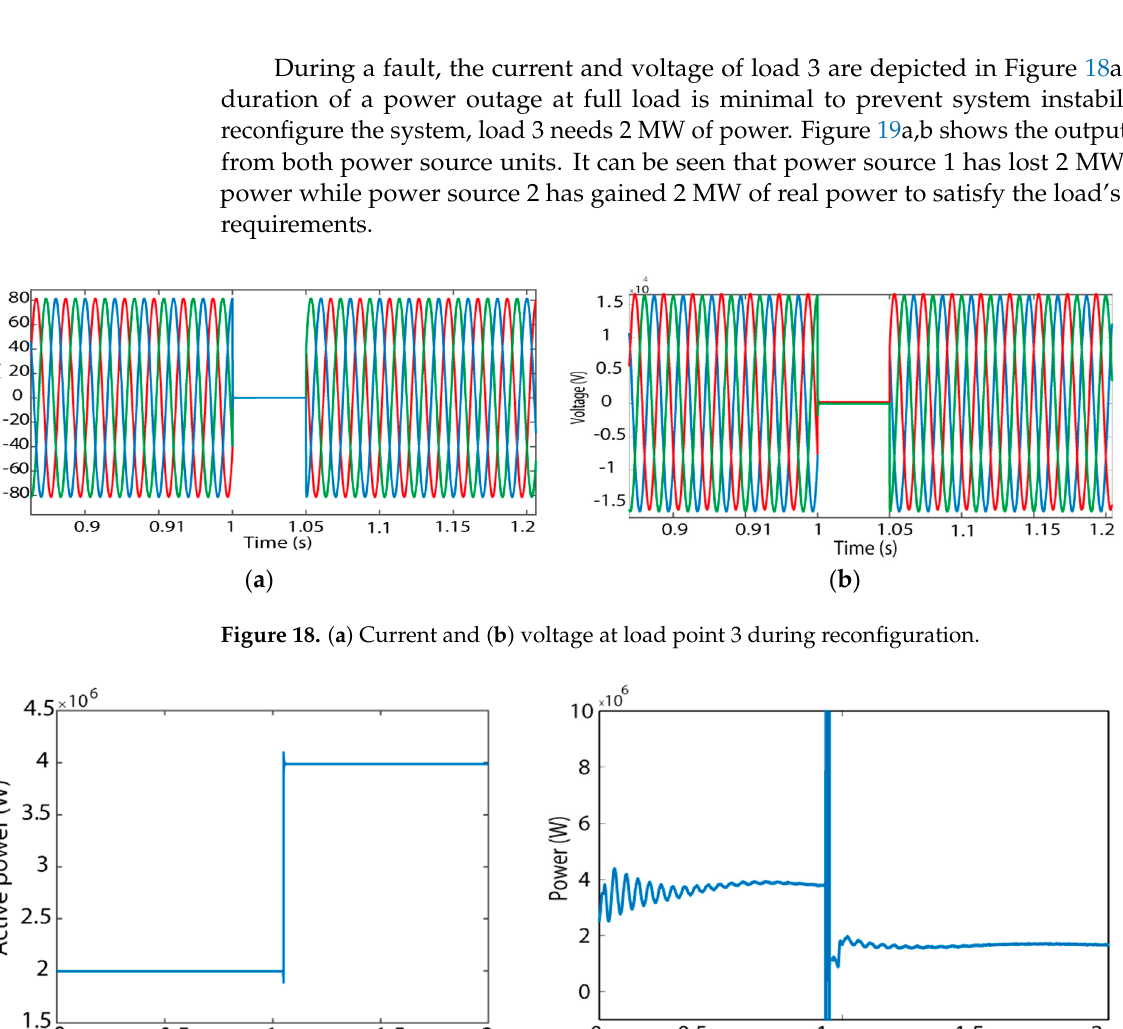
Figure 17. Breaker status for ( a ) CB8 and ( b ) CB9 during fault.